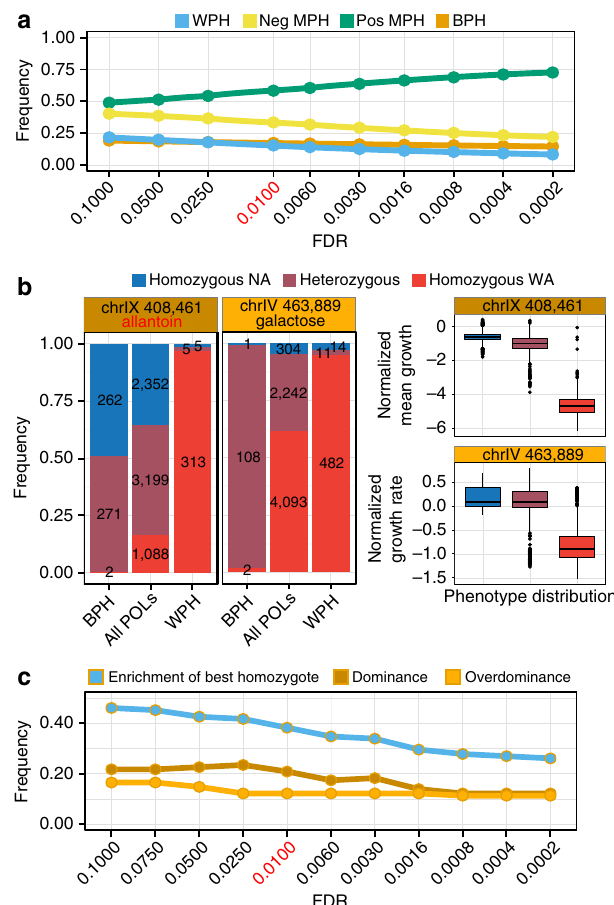
Figure 4 | Explaining heterosis by intralocus interactions. ( a ) Frequencies of the heterotic POLs ( y -axis) as a function of a range of FDR significance cut-off (q) values ( x -axis). Line colour ¼ type of heterosis. Red text ¼ FDR q -value chosen for downstream analysis ( a , c ). ( b ) Left panel: example of QTLs called as contributing to best parent heterosis by dominance (dark orange) and by overdominance (light orange) respectively. Dominance was called as enrichment of strongest homozygote and overdominance as enrichment of heterozygous state among BPH POLs as compared with all POLs (left panel). Right panel: phenotype (top: allantoin, bottom: galactose) distribution depending on genotype composition at the same QTLs. ( c ) The frequency of QTLs called as contributing by enrichment of the best homozygote, dominance and overdominance respectively ( y -axis) as a function of FDR significance cutoff ( q ) values ( x -axis). The dominance contribution is a subfraction of the contributions from enrichment of the best homozygote. Note: we show the outcomes of a range of FDR cut-off values to illustrate the robustness of conclusions; the cut-offs used for downstream analysis was set beforehand and not influenced by the results. Best parent heterosis (BPH); mid parent heterosis (MPH); worst parent heterosis